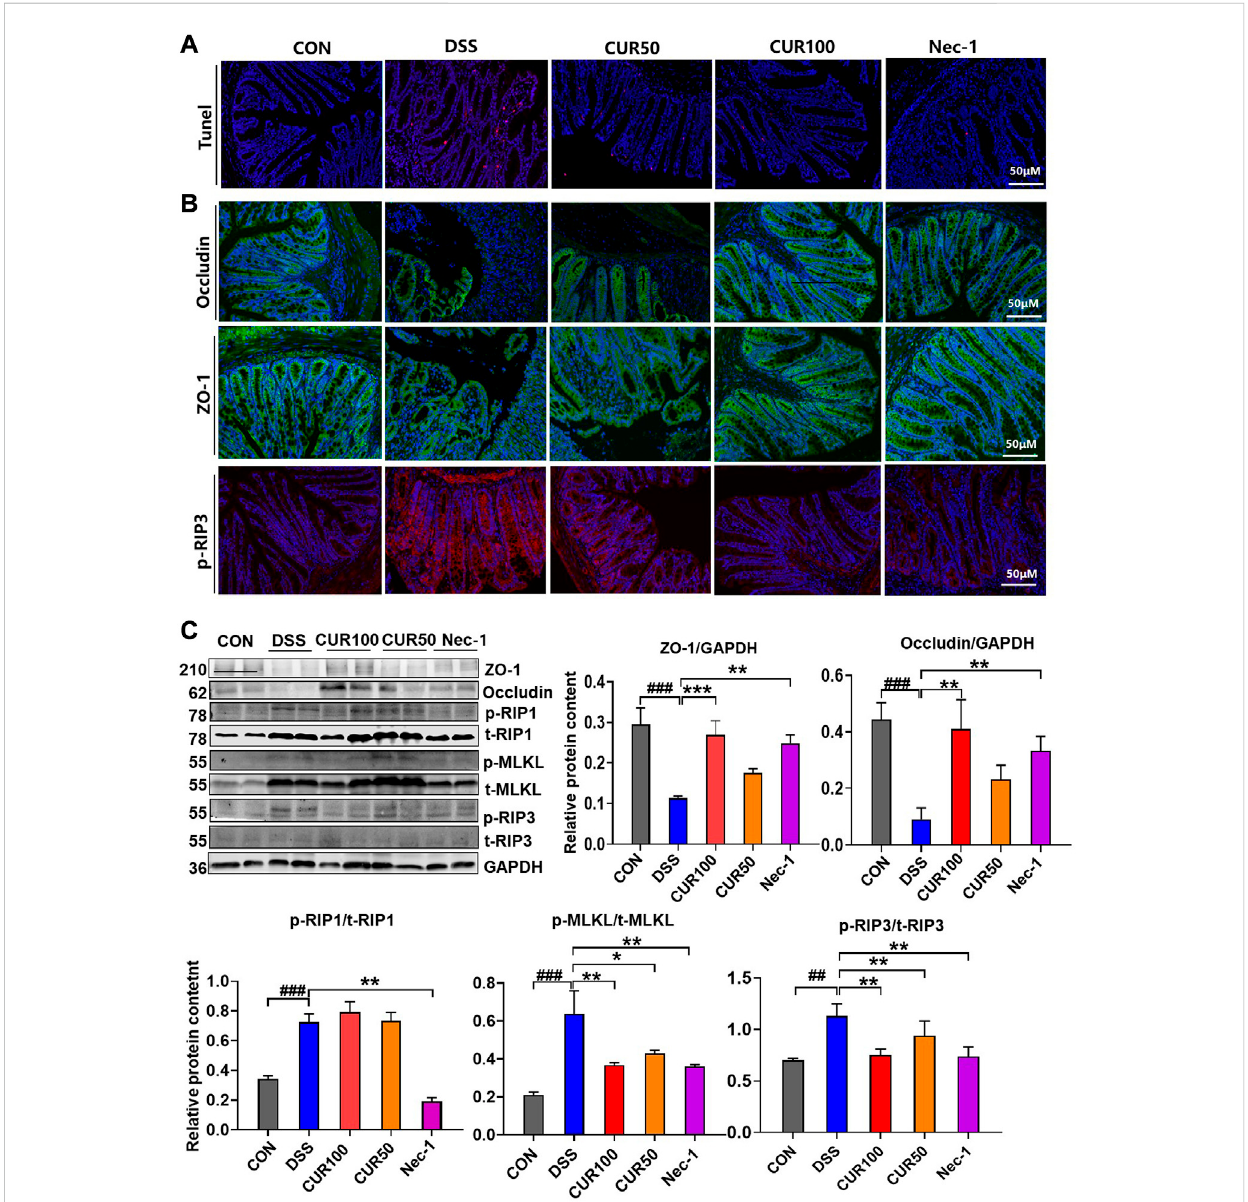
Curcumin inhibits intestinal epithelial necroptosis activation and tight junction barrier damage in mice with colitis. (A) Analysis of intestinal epithelial cell injuries by TUNEL. (B) Immuno fl uorescence staining showed intestinal epithelial TJ proteins including ZO-1 and occludin, and necroptosis-related proteinp-RIP3. (C) TheTJproteinsZO-1andoccludinandnecroptosis-relatedproteinsp-RIP1,p-RIP3,andp-MLKLweredetectedbyWesternblot.And quantitative analysis of gray scales of protein bands. (## p < 0.01, ### p < 0.001, compared with CON group; * p < 0.05, ** p < 0.01, *** p < 0.001, compared with DSS